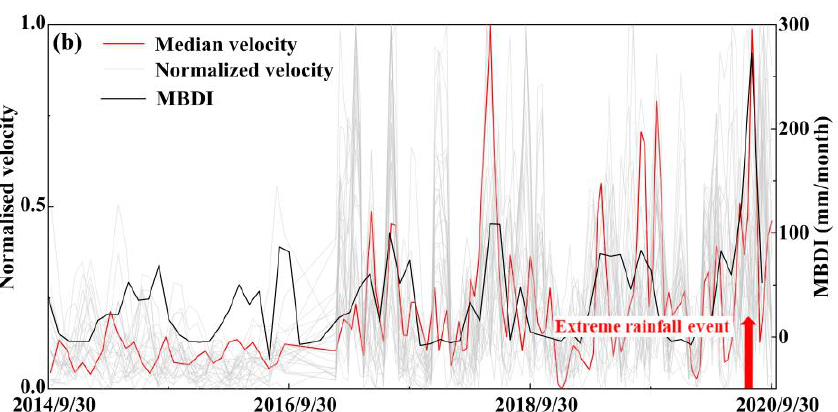
Figure 14. Normalized velocity time series and the moisture balance drought index (MBDI). ( a ) Eleven representative landslides from 2008 to 2010; ( b ) twenty-five representative landslides from 2014 to 2020.